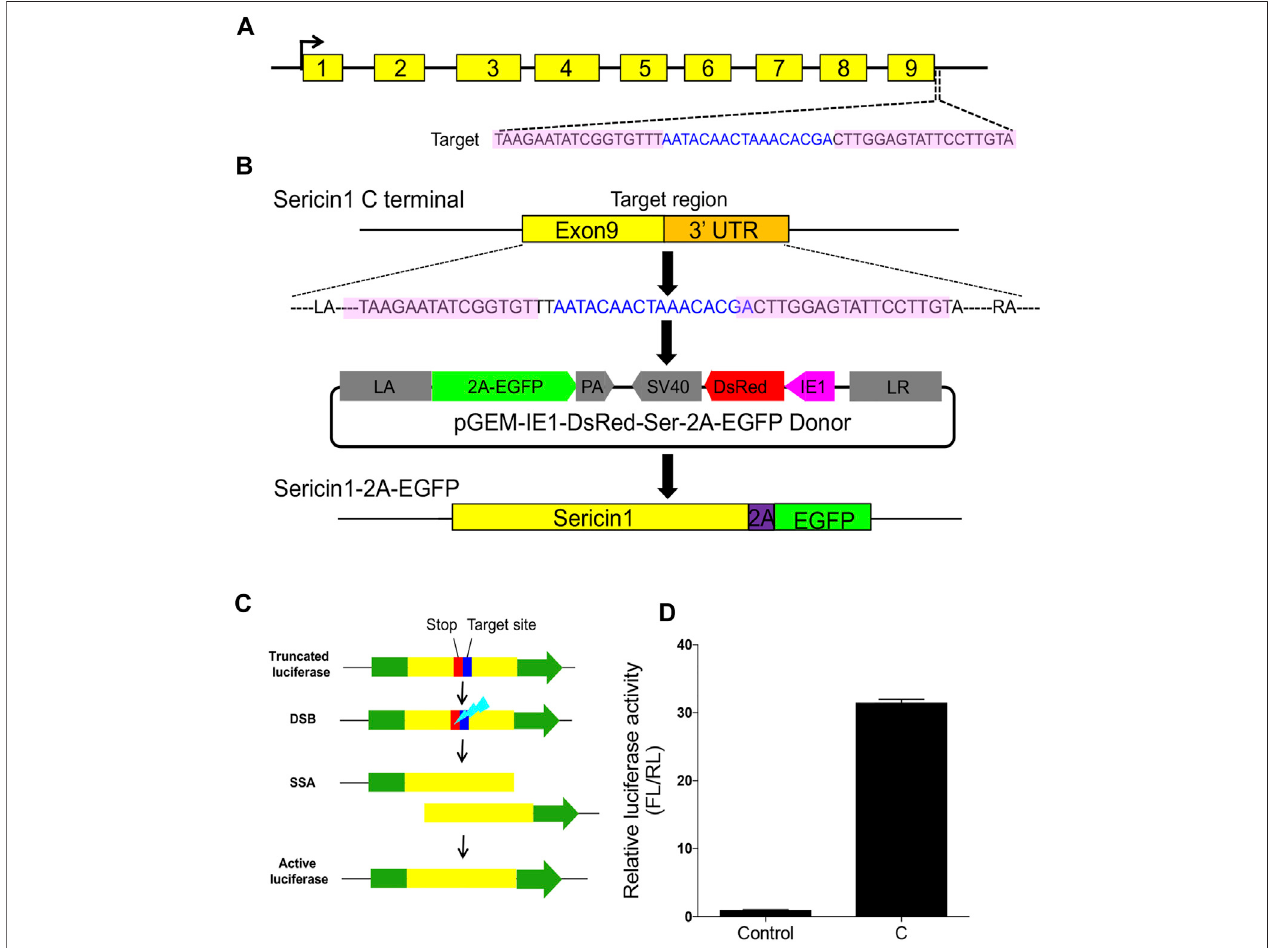
FIGURE 1 | Designing and construction of TALENs. (A) Structure of silkworm Sericin1 gene and the targeting sites of TALENs. The black arrows indicate the start codons. The black line is the genome DNA sequence and brown boxes represent Sericin1 exons. Sequences of TALENs are also listed, with pink shaded letters indicatingtheTALENrecognitionsitesandbluelettersarethespacers. (B) Schemeof2Aself-cleavagepeptide(purplebox)-mediatedsericin-EGFPin-fusionexpression on Sericin1 loci( Ser – 2A – EGFP ). (C) SchemaofSSAassayforTALENcuttingef fi ciency.Greenboxes are fi re fl yluciferase codingsequences,yellowboxes indicate therepeatfragment fl ankingthetarget site.Thestopcodon andtarget sitearepresented asred andblue boxes,respectively. (D) Luciferase activityoftheTALENsused for integration. The bars stand for mean ± S.E.M (n (cid:1) 3).